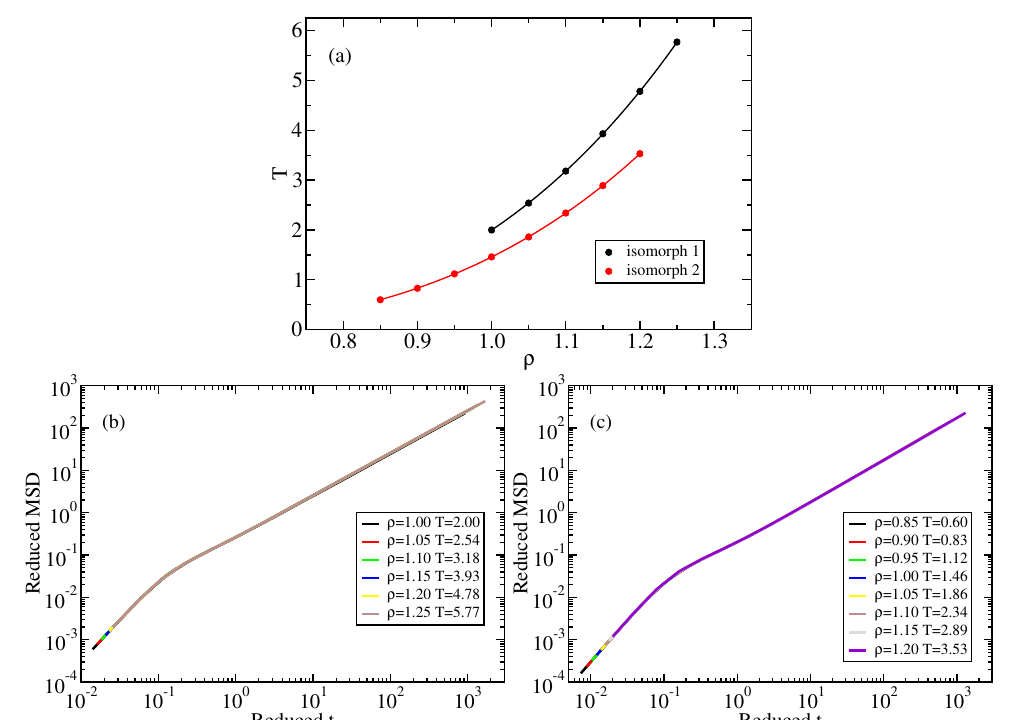
Figure 1. ( a ) The two LJ isomorphs studied. State points on the isomorphs were found by integrating Equation (4) numerically. ( b ) Mean-square displacement (MSD) for the state points of isomorph 1 plotted in reduced units, demonstrating good isomorph invariance of the dynamics. ( c ) The same for the state points of isomorph